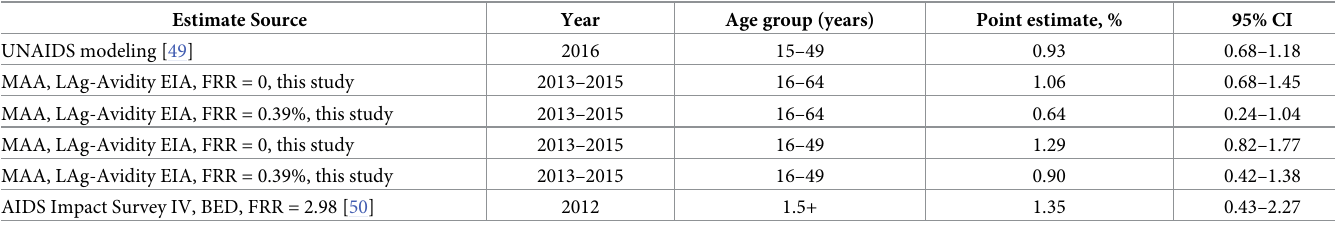
Table 2. Estimates of annualized HIV-1 incidence in